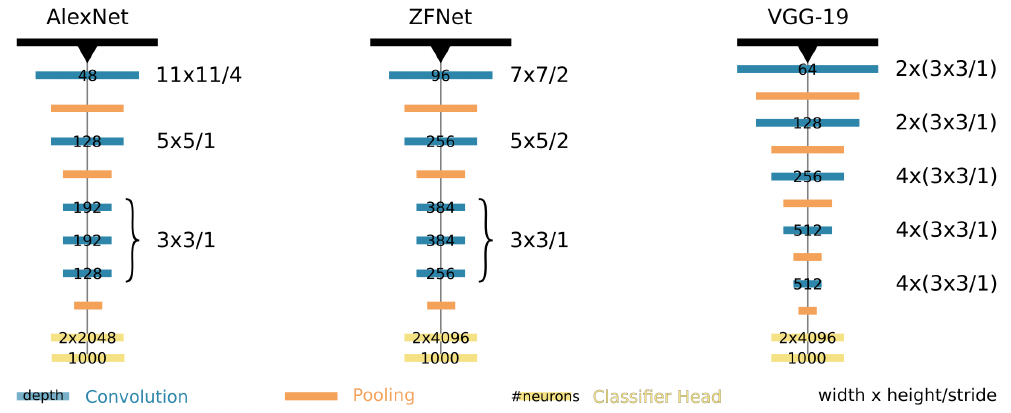
Figure 5. Conceptual overview of the Vintage Architectures . The architecture designs of AlexNet [3] and ZFNet [38] are similar despite smaller kernel in the first convolutional layers and deeper feature maps in ZFNet, whereas VGG-19 [39] is considerably deeper overall and it uses a uniform kernel